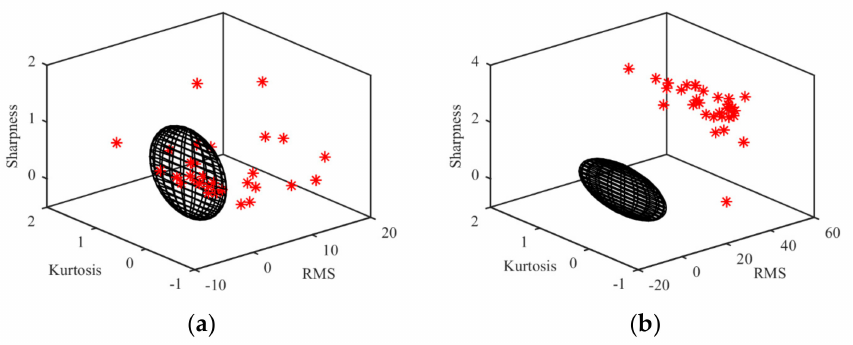
Figure 17. Flywheel #6 test noise sample point and security domain: ( a ) 3000 r / min; ( b ) 4600 r / min.